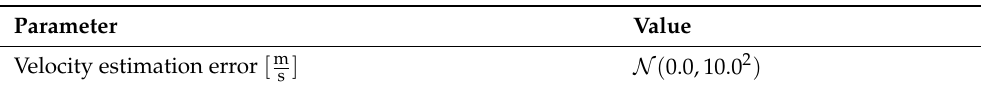
Table A8. Distributions of Scenario C parameters. Ego and object initial state parameters are identical as in Scenario B.